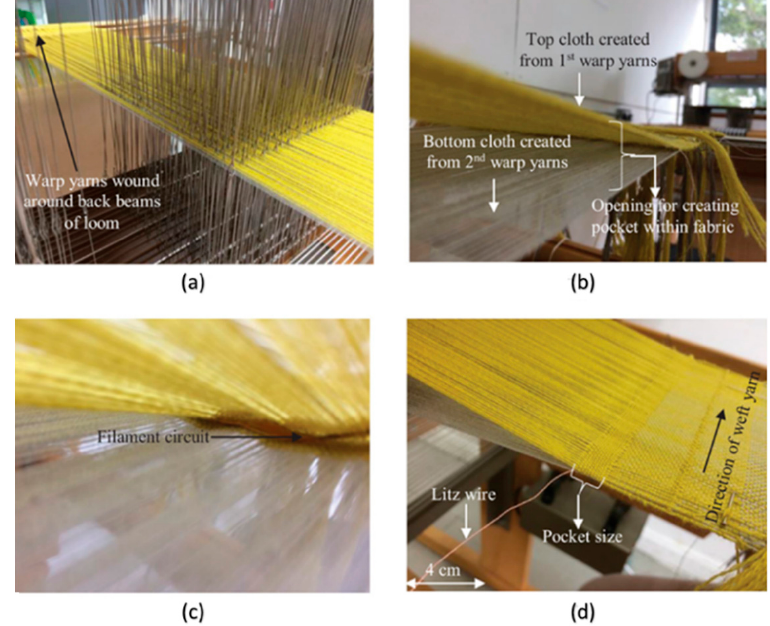
Figure 3. Example weaving process for integrated e-textile fabrication: ( a ) warp yarns on programmable dobby loom, ( b ) weaving of double weave structure, ( c ) insertion of filament circuit and ( d ) closure of pocket and trailing wire.